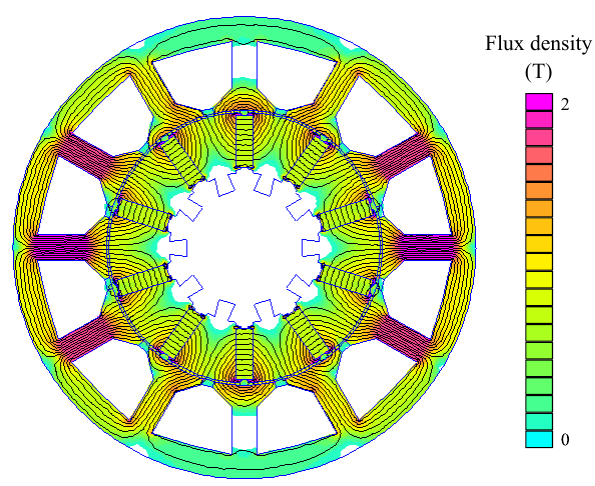
Figure 18. No-load air gap flux lines and flux density of the 12/10 spoke-type IPM motor. Figure 19a shows the flux linked by phase A and the d-axis flux-linkage in a mechanical period (which corresponds to 360 electrical degrees, as the electrical angle is equal to p times the mechanical angle). The waveform of phase A flux-linkage is almost sinusoidal, as confirmed by the constant value of the d-axis flux-linkage and the Fourier analysis of Figure 19b. A very low third harmonic is present.